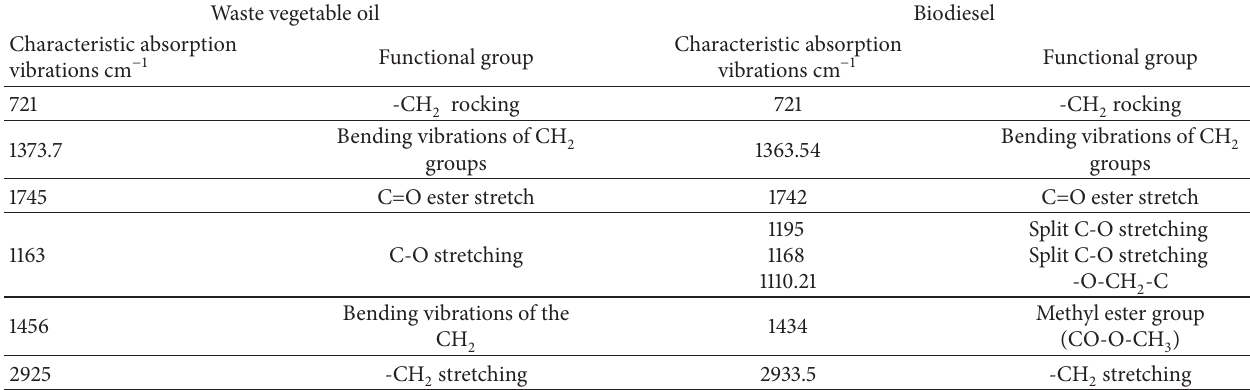
Table 4: FT-IR main characteristic band positions for waste vegetable oil and prepared